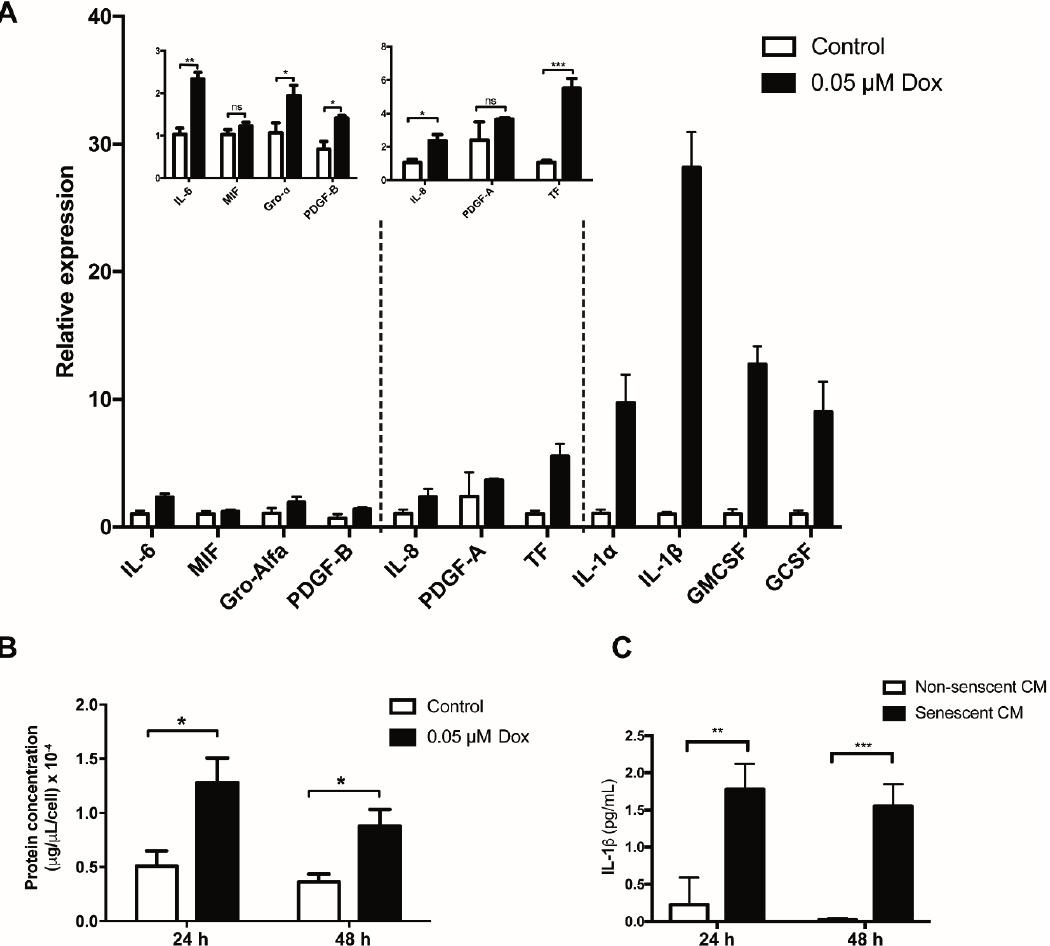
Figure 2. Expression of selected senescent-associated secreted factors in senescent HMEC-1 cells. ( A ) qRT-PCR-based expression analyses of selected SASP factors in doxorubicin (Dox)-treated HMEC-1 cells. ( B ) Total protein concentration, corrected by cell number, in conditioned media generated by senescent and non-senescent (control) cells. ( C ) Protein levels of IL-1 β present in conditioned media from senescent and no-senescent HMEC-1 cells were determined by ELISA. Error bars indicate mean ± SD of n = 3 (NS = not significant; * p < 0.05; ** p < 0.01; *** p < 0.001; t -student test).